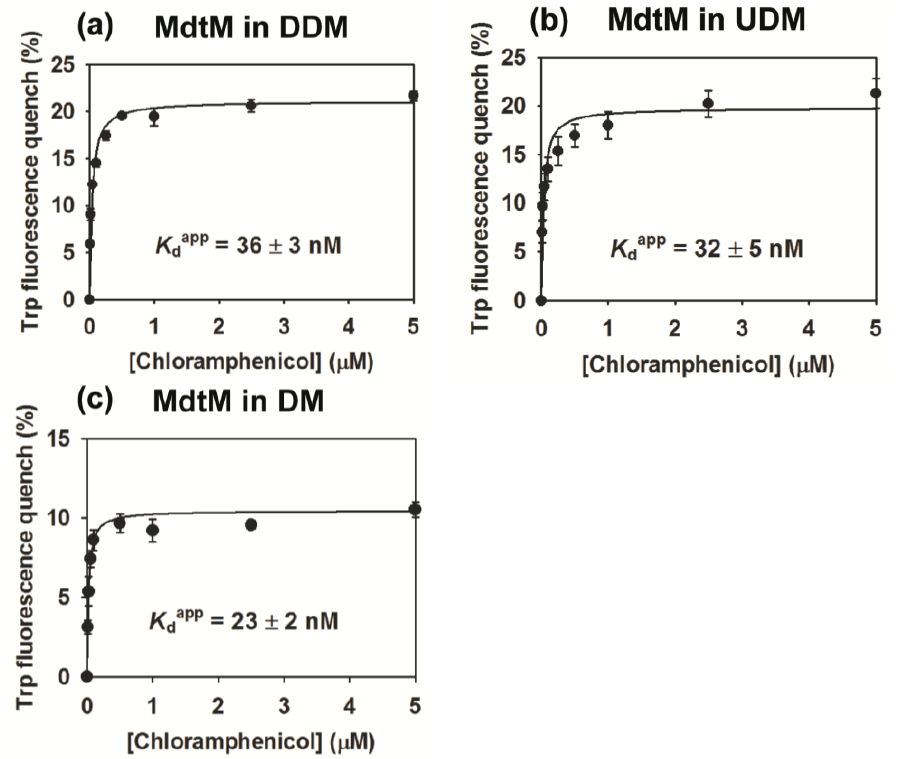
Figure 4. Substrate-binding affinity curves for chloramphenicol binding to MdtM in different detergents. ( a ) Binding affinity of chloramphenicol for MdtM in DDM; ( b ) Binding of affinity of chloramphenicol for MdtM in UDM; ( c ) Binding affinity of chloramphenicol for MdtM in DM. Data points and error bars represent the mean ± SD of three individual